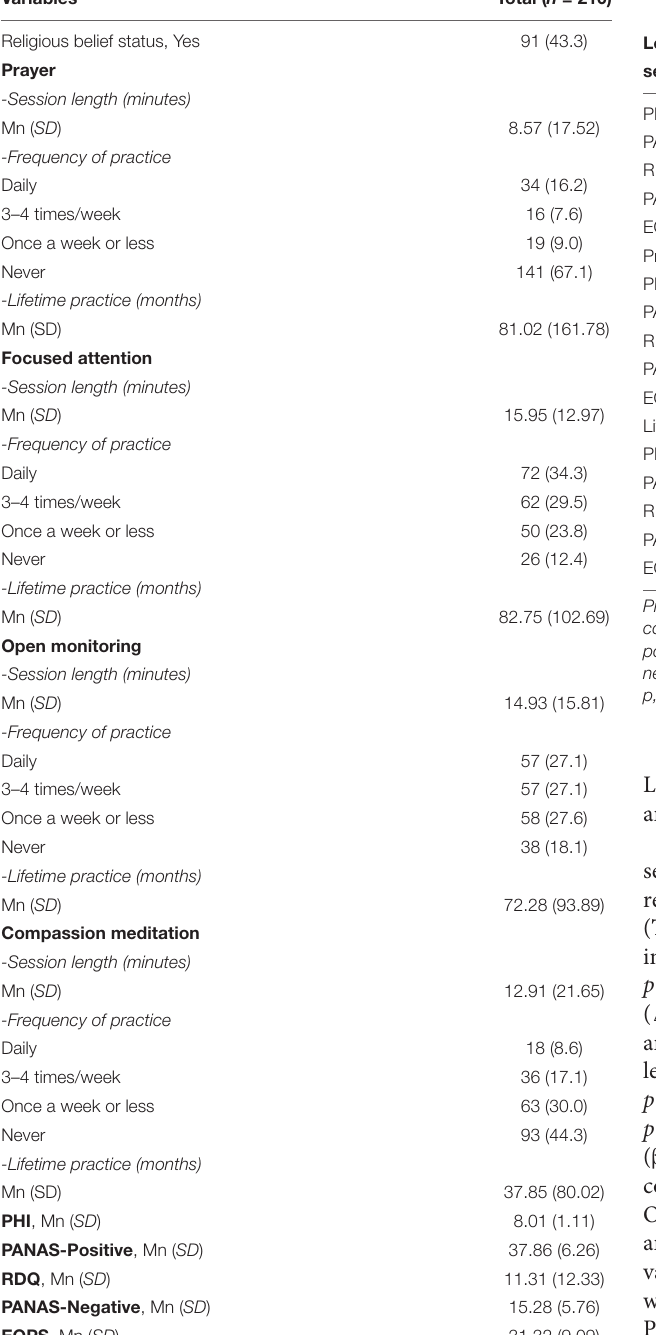
TABLE 2 | Raw relationships between the practice-related variables of prayer and meditation techniques and the different psychological adjustment outcomes. Prayer FA OM CM Length of